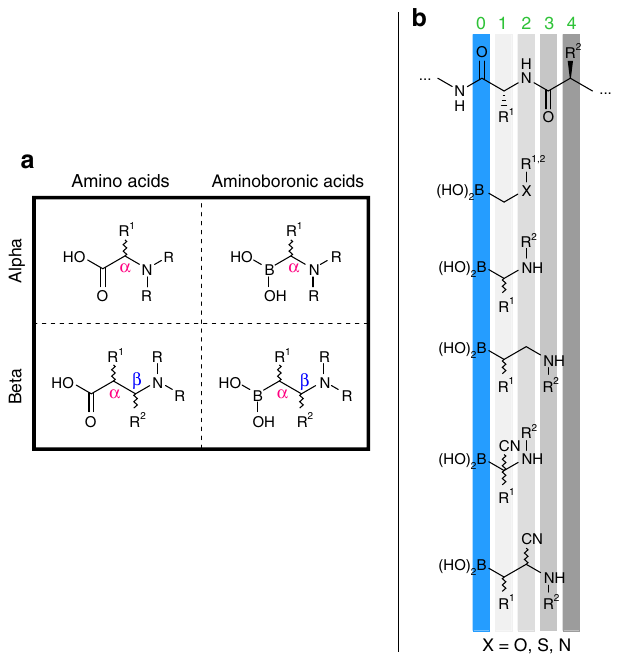
Fig. 1 An overview of the α - and β -aminoboronic acids investigated in this study. a A comparison of the structural similarities between amino acids and aminoboronic acids. b A comparison of the structural relations between the peptide backbone and the aminoboronic acid frameworks investigated in this